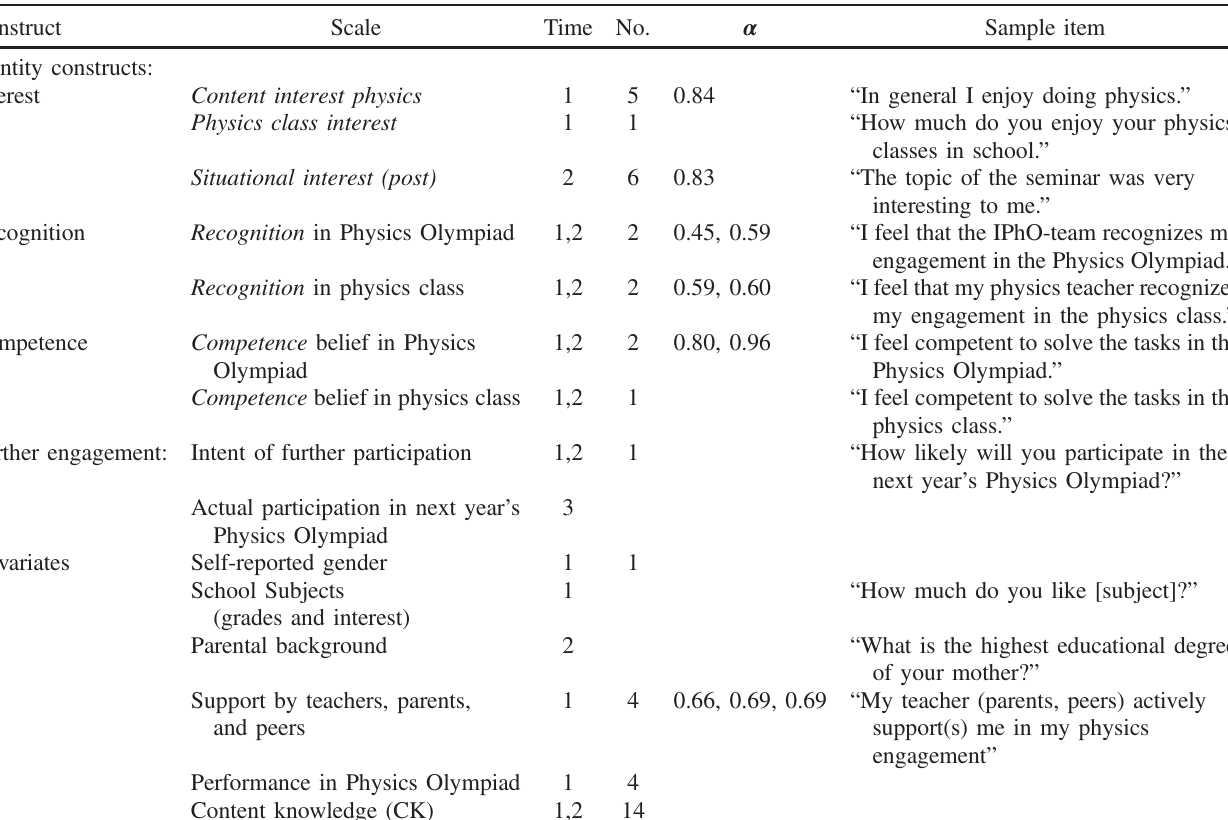
TABLE I. Overview of instruments that were measured in the intervention. Construct Scale Time